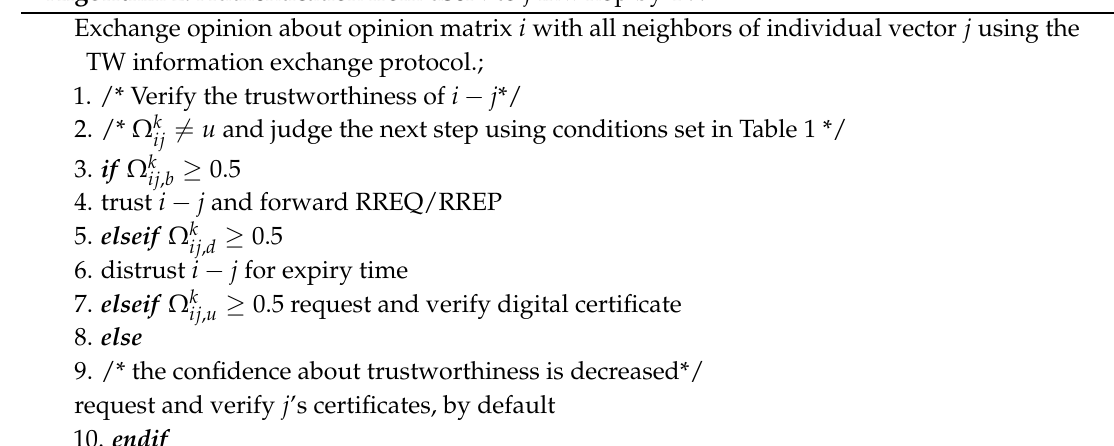
Algorithm 2: Authentication from user i to j in k -hop by